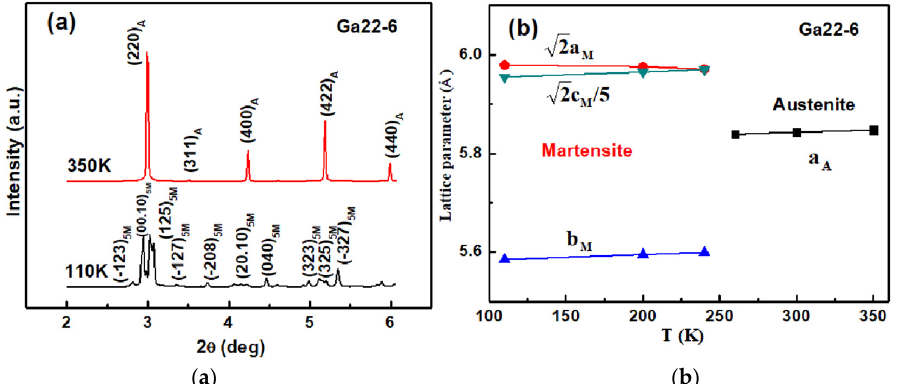
Figure 9. High-energy X-ray diffraction patterns experimentally collected at 350 K and 110 K for Ga22-6 ( x = 8) alloy ( a ). The corresponding temperature dependence of the lattice parameters ( b ).